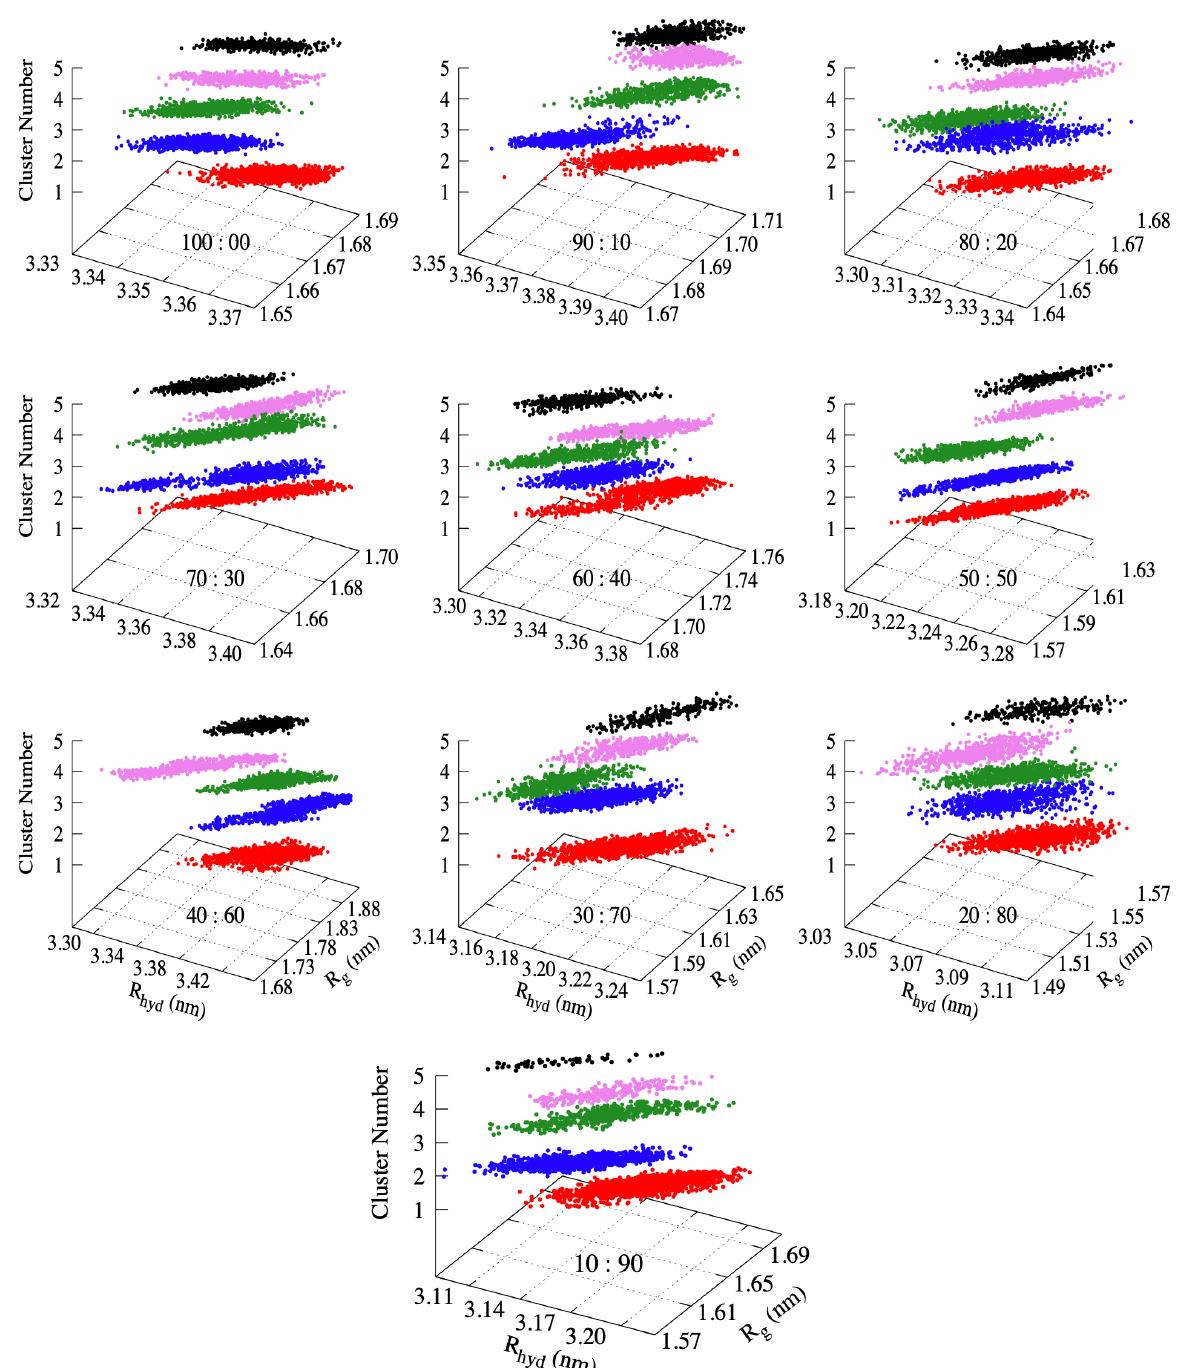
Figure 6. Cluster distribution along the MD trajectory of the RVFV domain from the hierarchical agglomerative clustering algorithm. The radius of gyration vs hydrodynamic radius of peptide over the trajectory which is colored based on their cluster memberships along the 200ns MD runs at